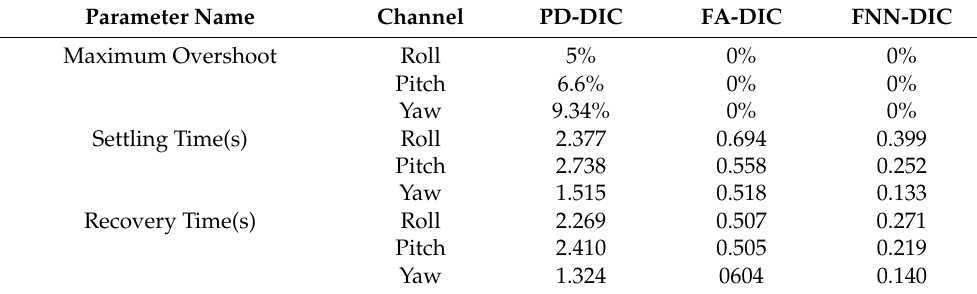
Table 4. Performance metrics of the three controllers of the attitude system.